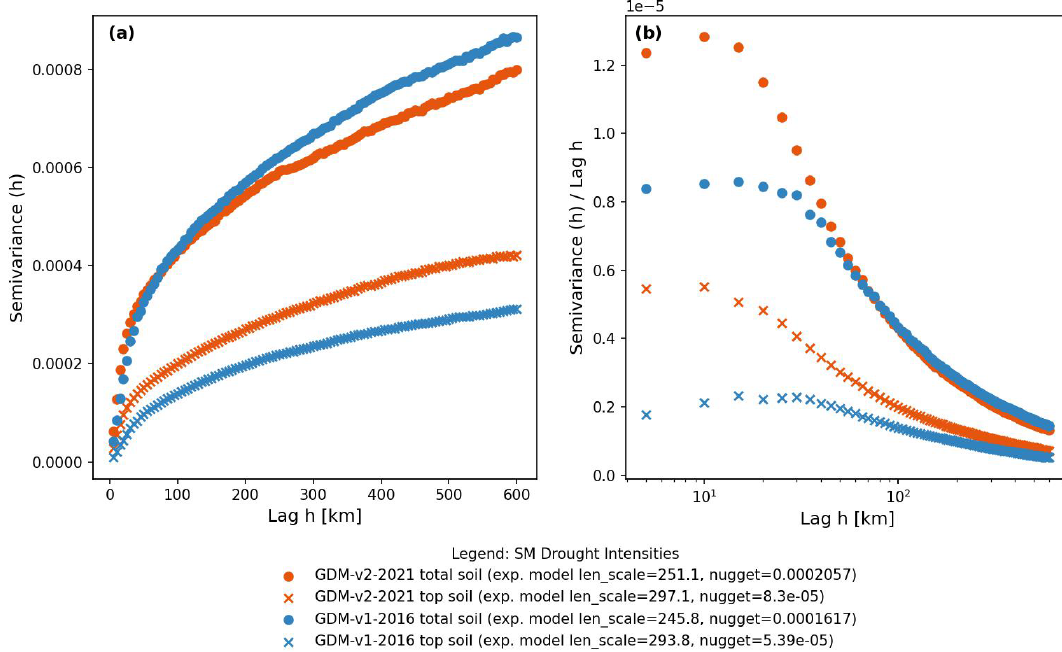
Figure 10. Empirical semi-variograms for drought intensities during the vegetative active period in upper soil for the GDM-v1-2016 and the GDM-v2-2021 setups. The bin size was set to 5km, which corresponds to the nearest, larger, even kilometer bin size relative to the GDM- v2-2016 modeling resolution. The length scale and nugget of the fitted exponential theoretical semi-variograms are noted in the legend. Subplot (b) shows the semivariance normalized by distance, and the x axis is log